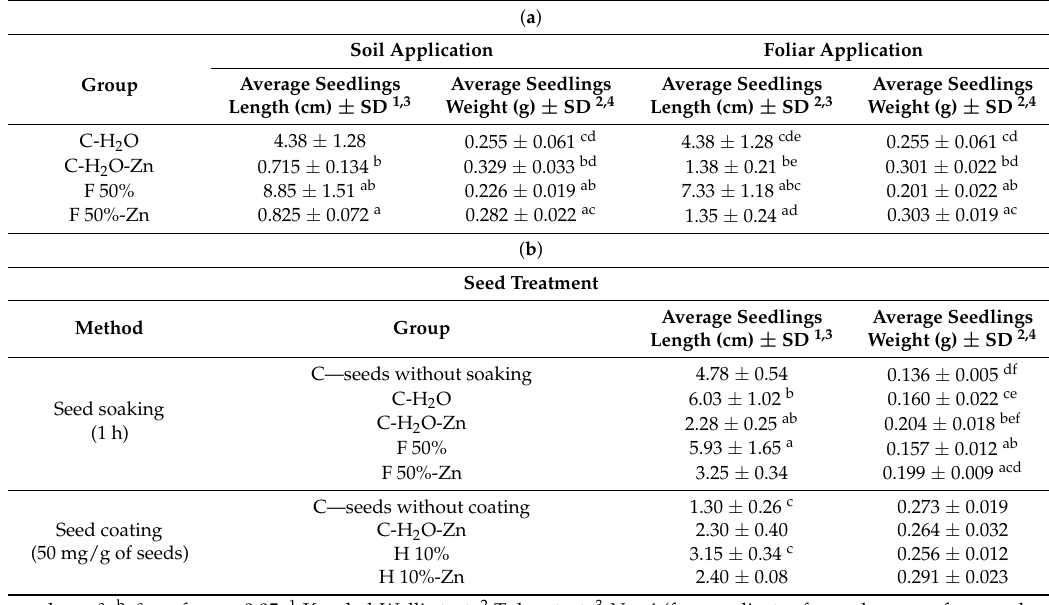
Table 5. The final tests on seedlings with the selected algal products: ( a ) method of application—soil and foliar; ( b ) seed treatment—soaking and coating ( N =